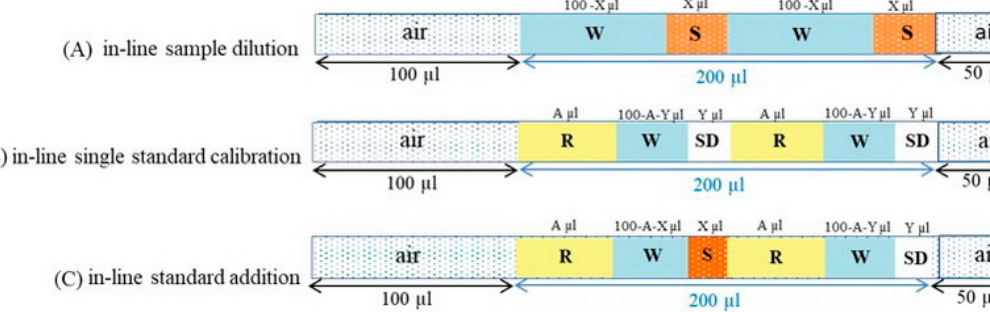
Figure 6. Operational sequences for ( A ) in-line sample dilution, ( B ) in-line single standard calibration,